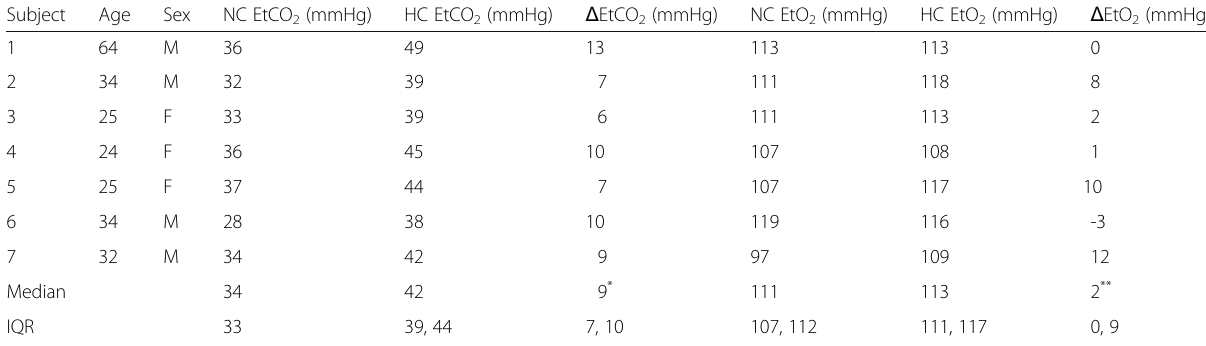
Table 1 Baseline characteristics and end-tidal CO 2